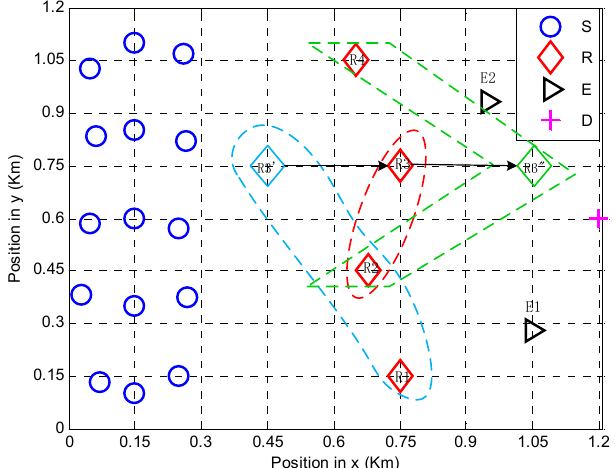
Figure 3. Coalition structure with the movement of R 3.